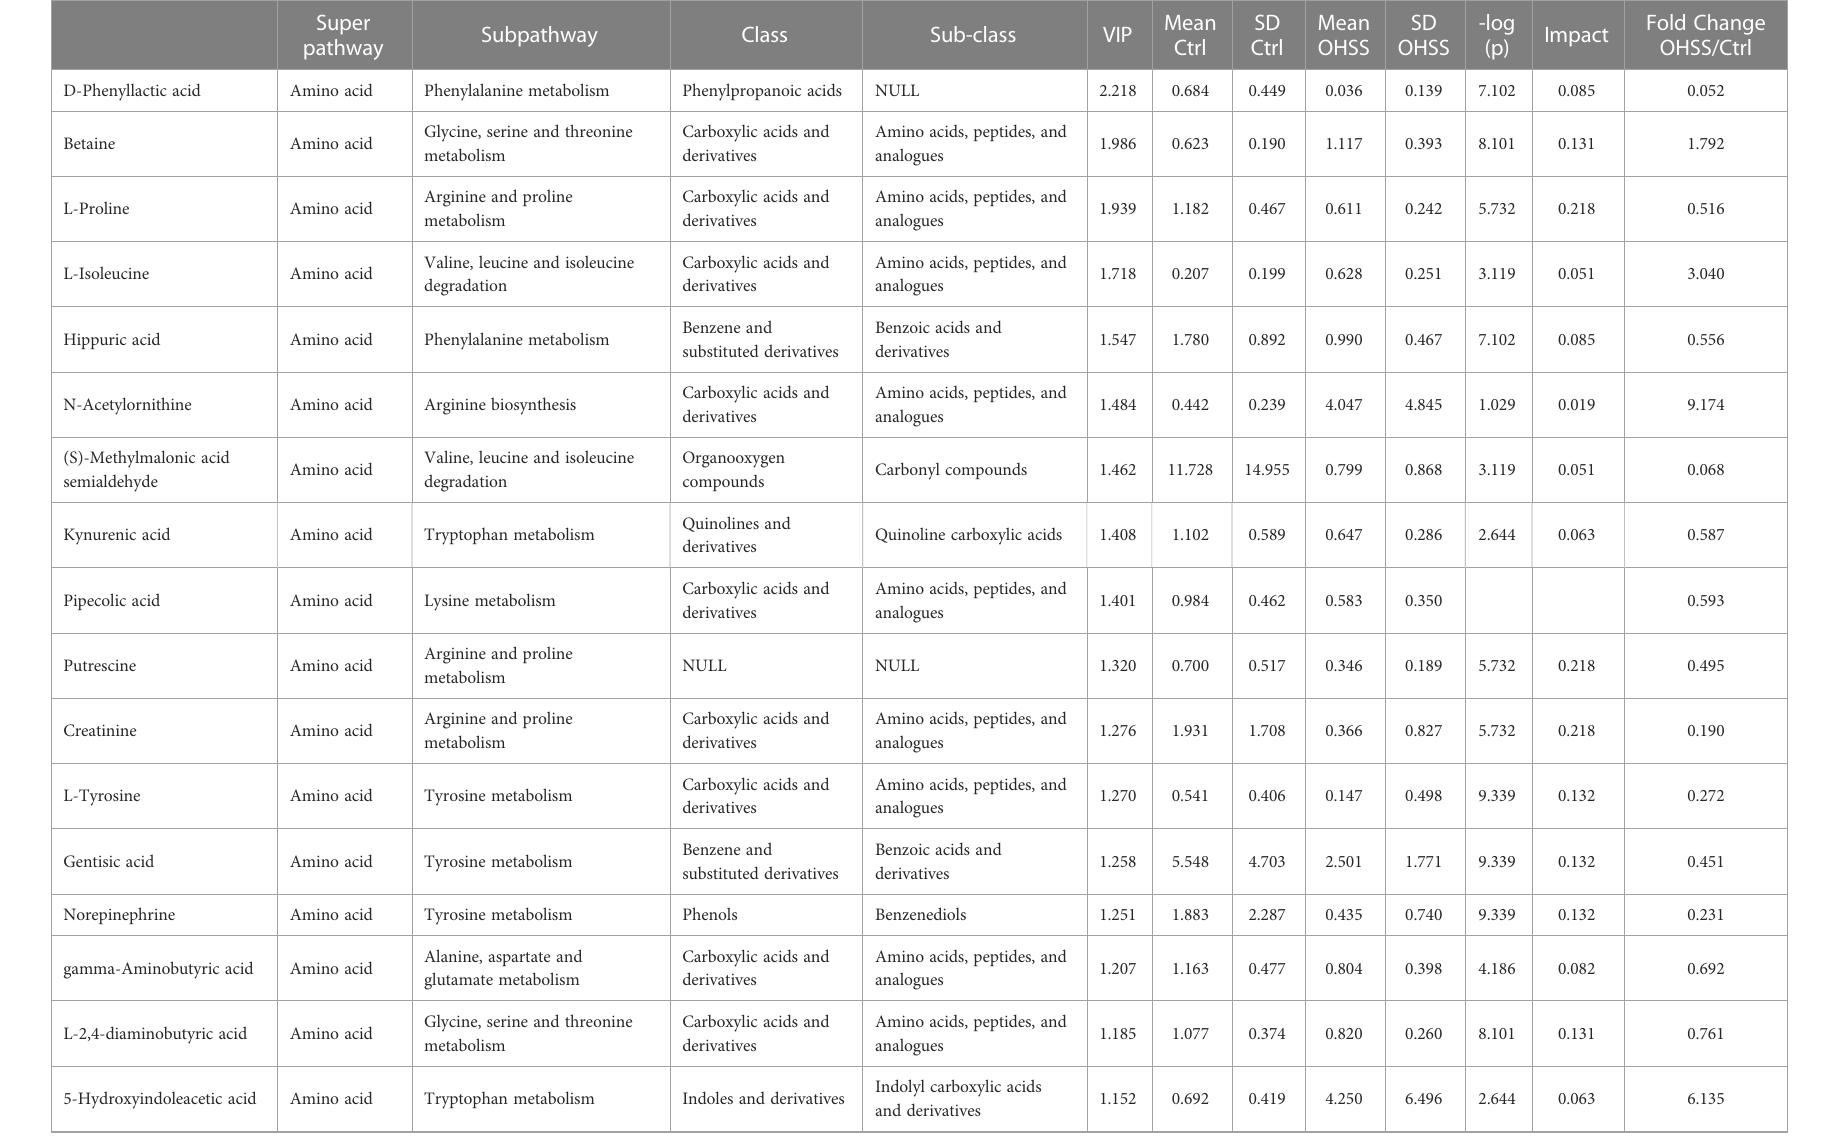
TABLE 2 Differentially changed metabolites that varied in OHSS FF with signi fi cant